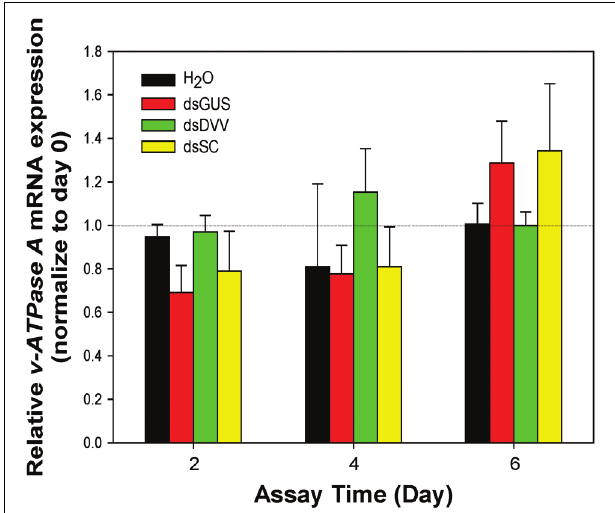
FIGURE 4 | Temporal profile of v-ATPase A expression in S. curviseta . The expression profile of S. curviseta v-ATPase A was documented on days 2, 4, and 6. The relative expression of v-ATPase A transcripts was normalized to a reference gene 28S rRNA , and the transcription level of v-ATPase A in the 10-days-old untreated larvae were set to 1. See text for treatment details. Values are mean ± SE.